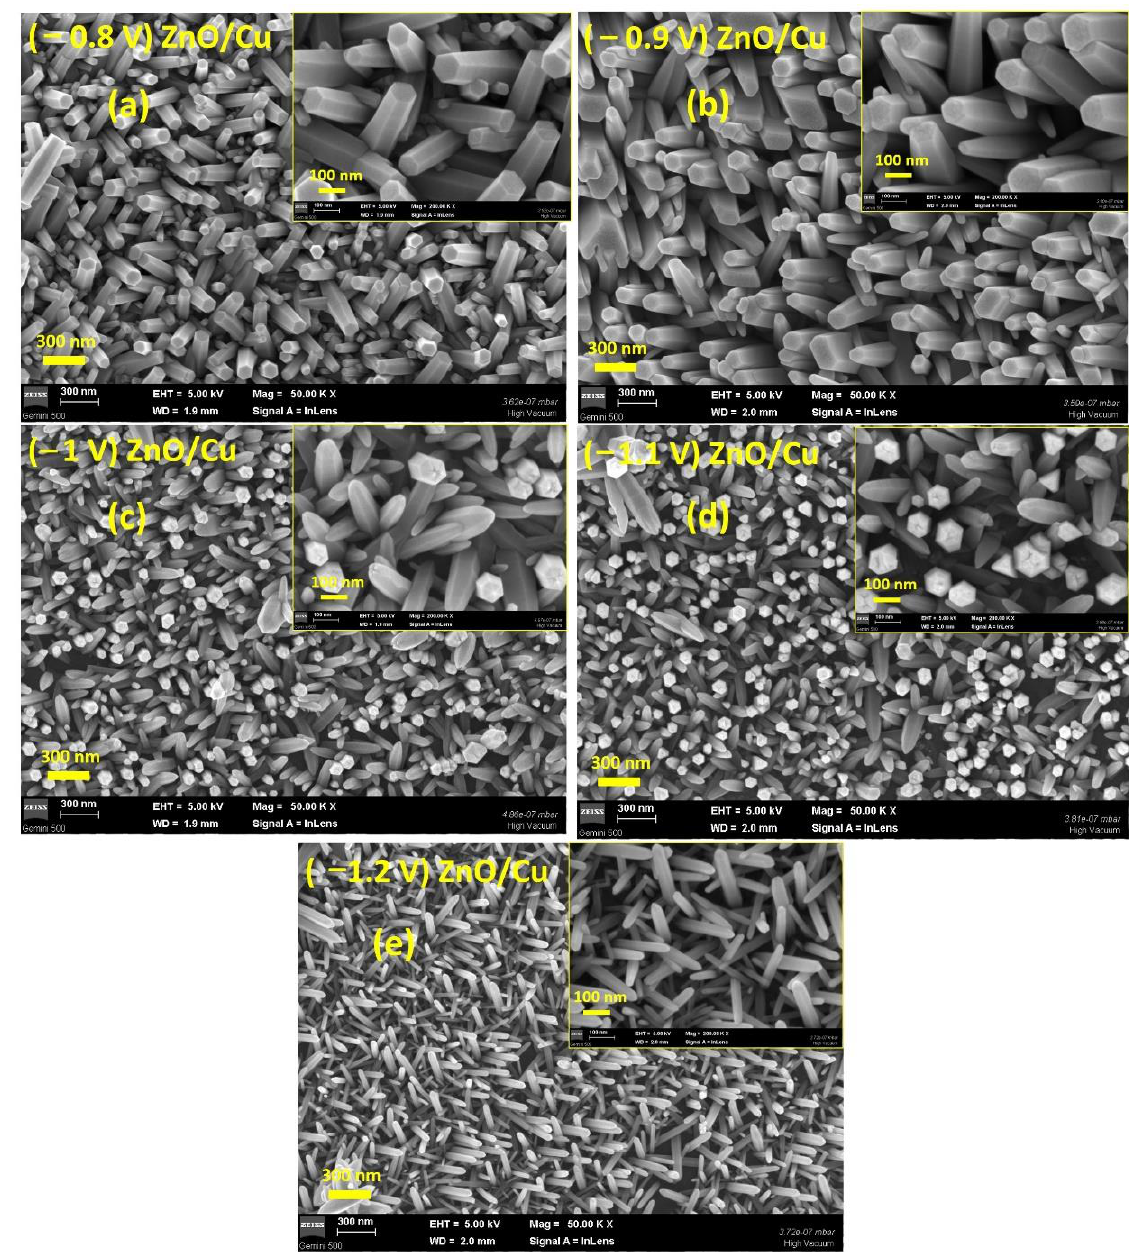
Figure 6. SEM images of ZnO nanowires grown on Cu substrate at different potentials: ( a ) −0.8 V, ( b ) −0.9V, ( c ) −1 V, ( d ) −1 .1V, ( e ) −1 .2 V vs. RE. The insets show the SEM images at high magnification.